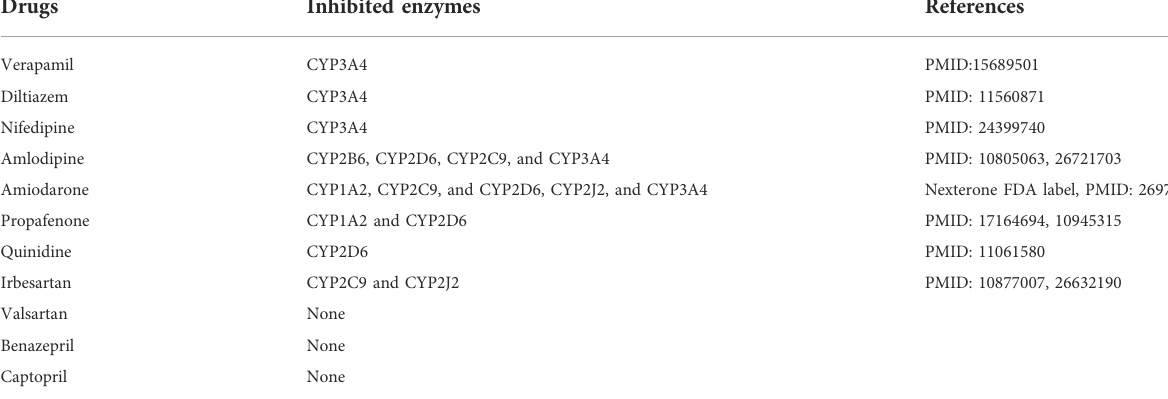
TABLE 1 The enzymes that eleven commonly used cardiovascular drugs mainly